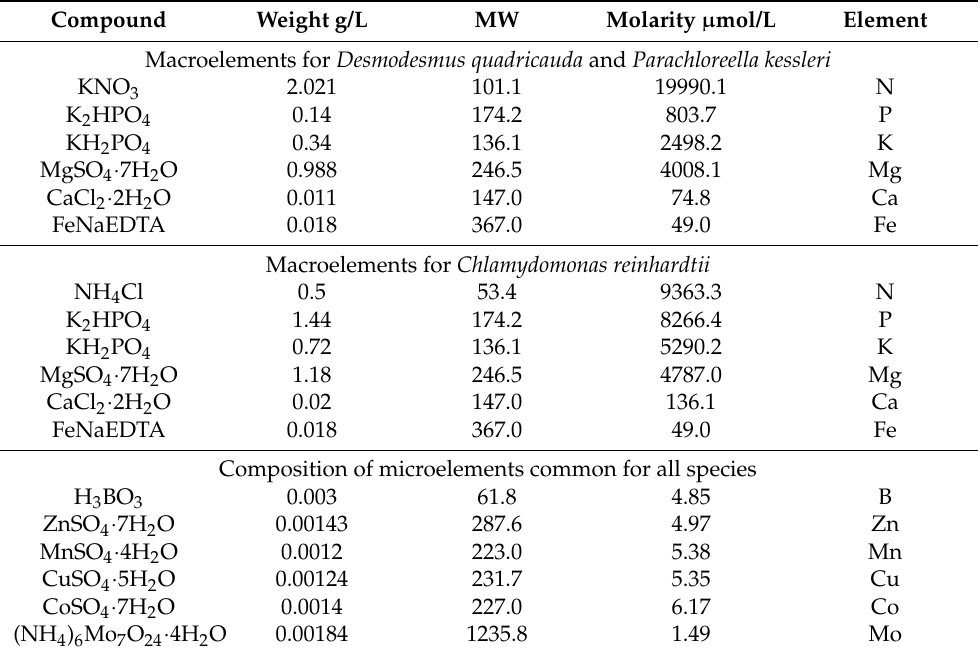
Table 4. Composition of nutrient media for all experimental species.